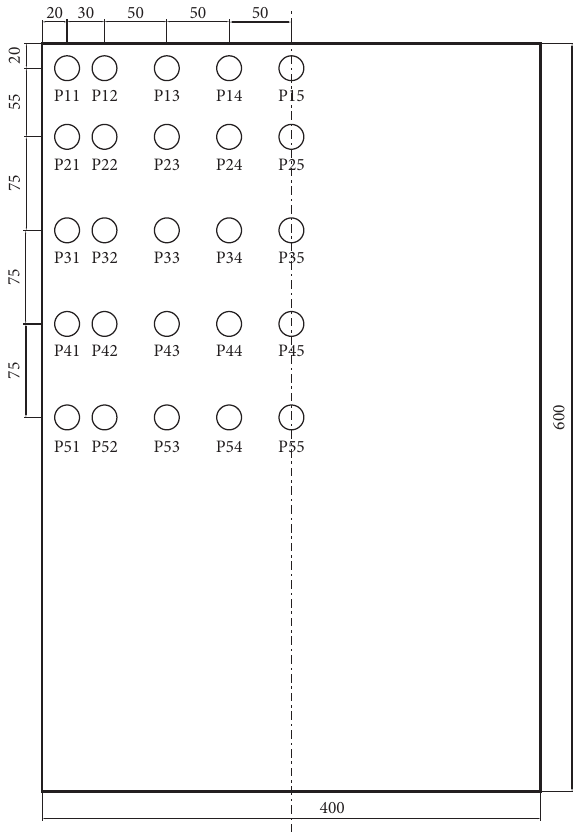
Figure 1: Distribution of the void position in the forging